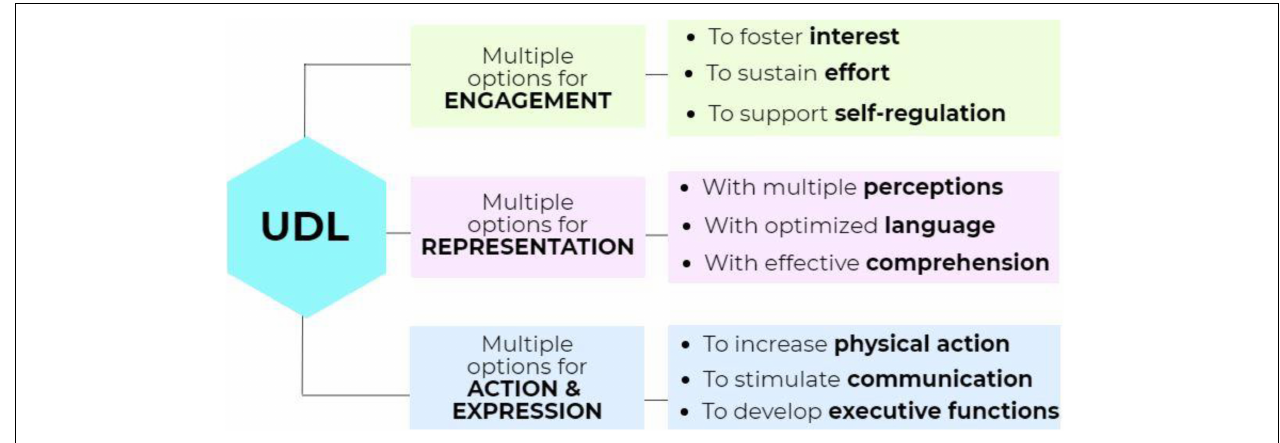
FIGURE 1 | UDL Framework (adapted from CAST,